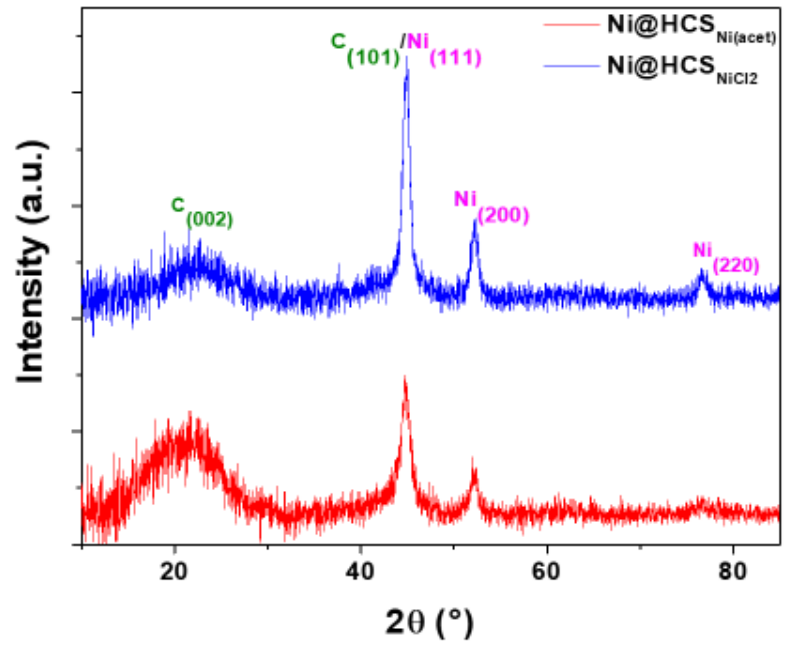
Figure 5: PXRD patterns of the Ni@HCSs nanocatalysts prepared using different Ni-precursors. Figure 5. PXRD patterns of the Ni@HCSs nanocatalysts prepared using different